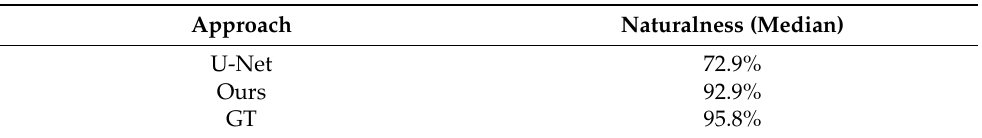
Figure 8. Boxplots of the naturalness of the images evaluated by different users. The 92.9% of our colorization network is closer to the 95.8% of ground truth than the 72.9% of the base U-Net. This indicates that our algorithm generates more natural color pictures. Table 4. Naturalness of user study. The values show that our network generates more vivid color pictures as compared with the base